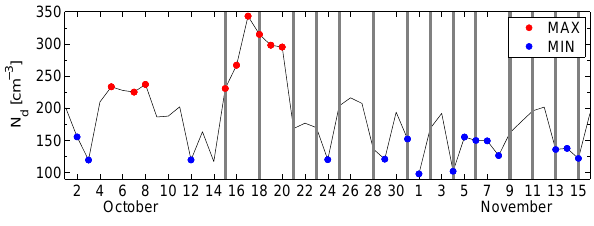
Fig. 12. VOCALS-REx spatial-mean N d time series over the Arica Bight with MAX and MIN cases highlighted in red and blue respec- tively. NCAR flight days are indicated with grey bars. Twin Otter flights to Point Alpha (75W, 20S) coincided with MAX/MIN cases on 16, 18, 19, 24 and 29 October.